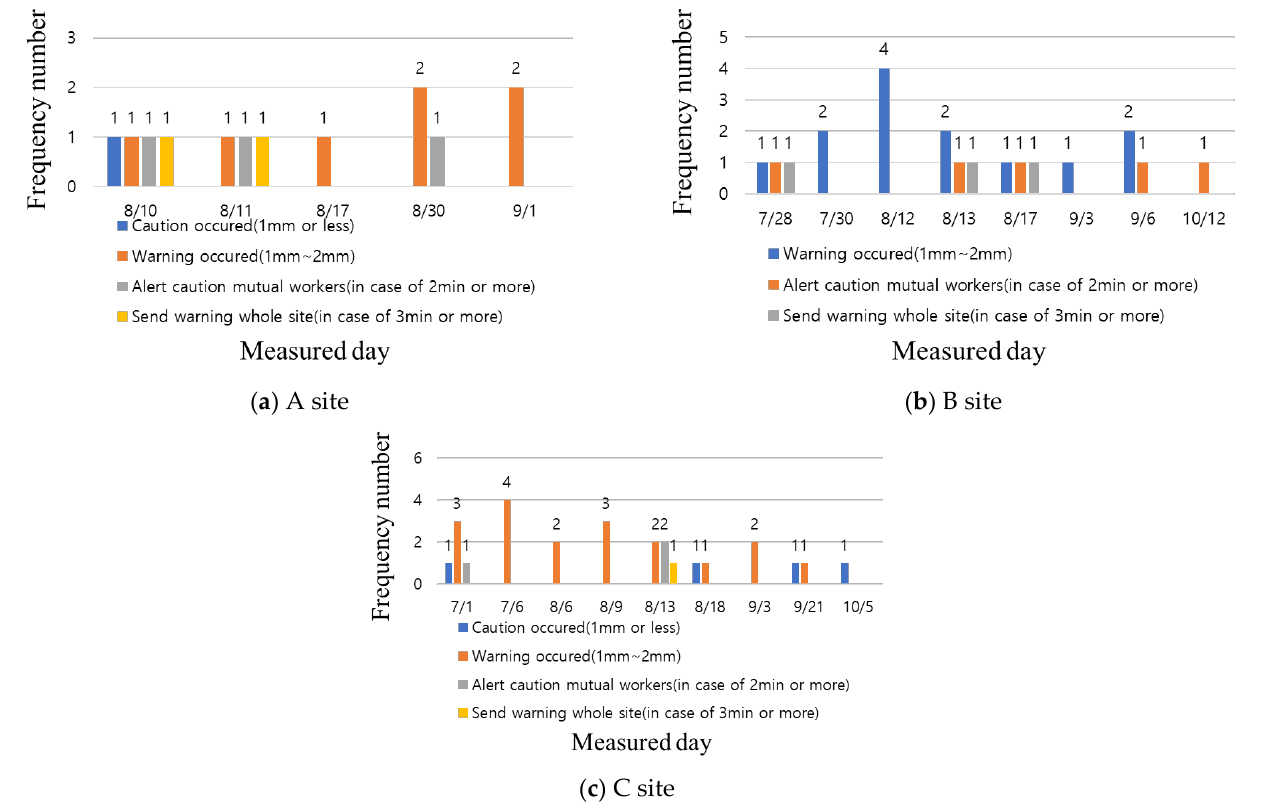
Figure 12. Analysis of hazardous gas detector data for test beds.